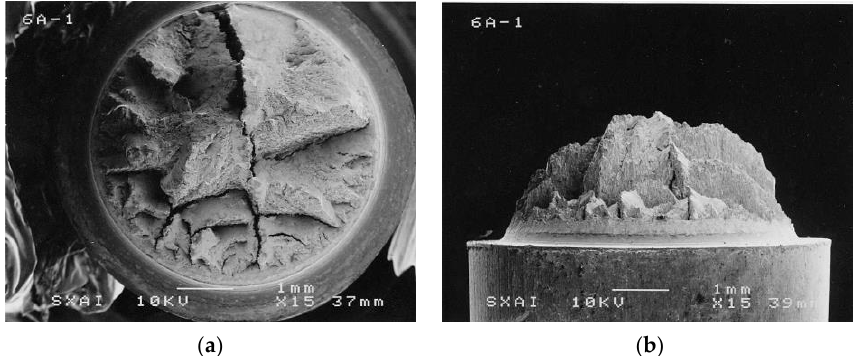
Figure 5. Sample 6A with anisotropic fracture behavior: front view ( a ) and side view ( b ).